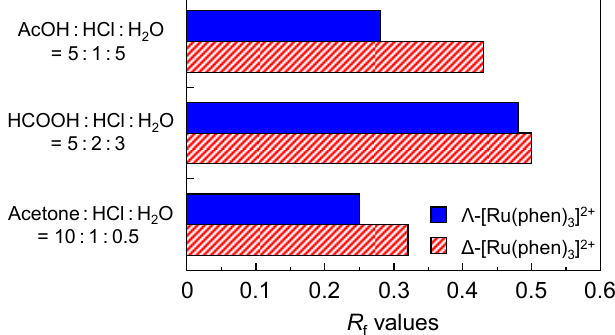
Figure 3. R f values of Λ - and ∆ -[Ru(phen) 3 ] 2+ on the DNA-TLC plate. Each of the values represents the mean of three separate determinations.